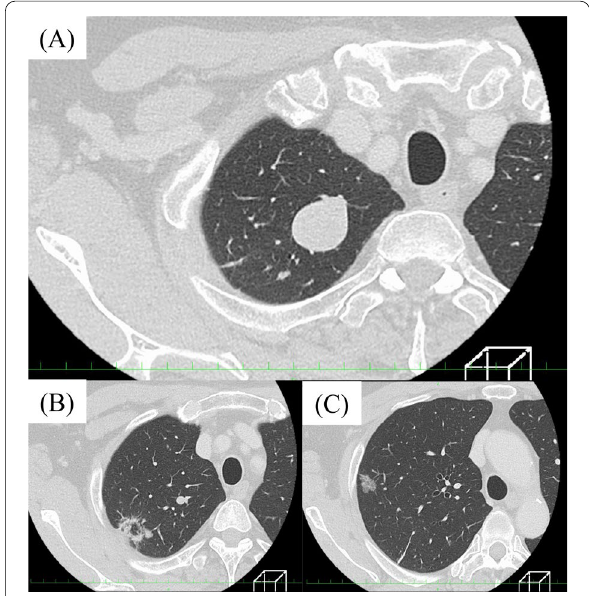
Fig. 1 A computed tomographic scan of the chest shows showed a well-defined nodule with punctate calcification ( A ) and two ground-grass nodules with solid component ( B )